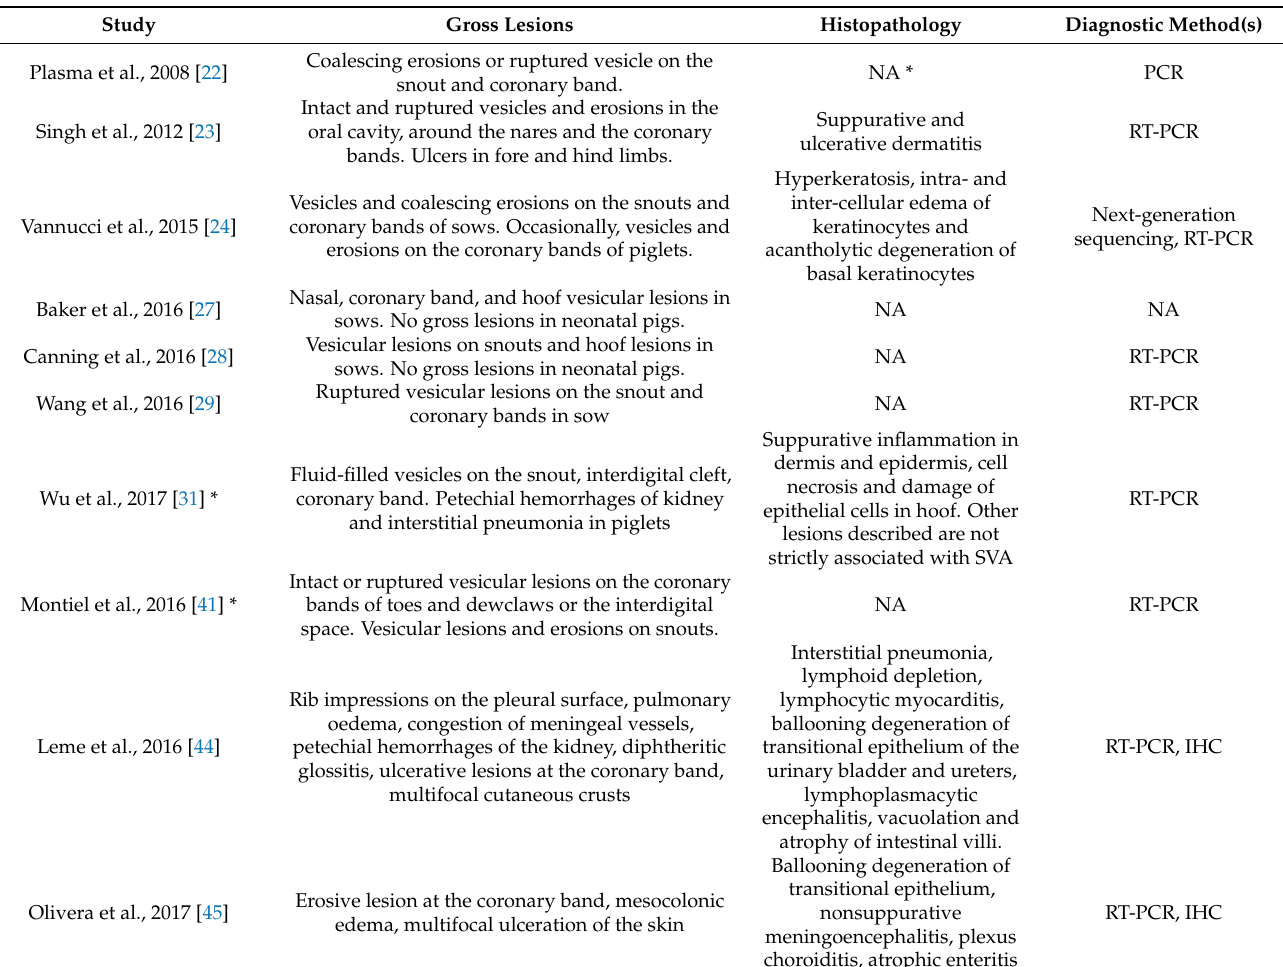
Table 1. Main scientific studies describing the gross and histological lesions and diagnostic methods applied for Senecavirus A